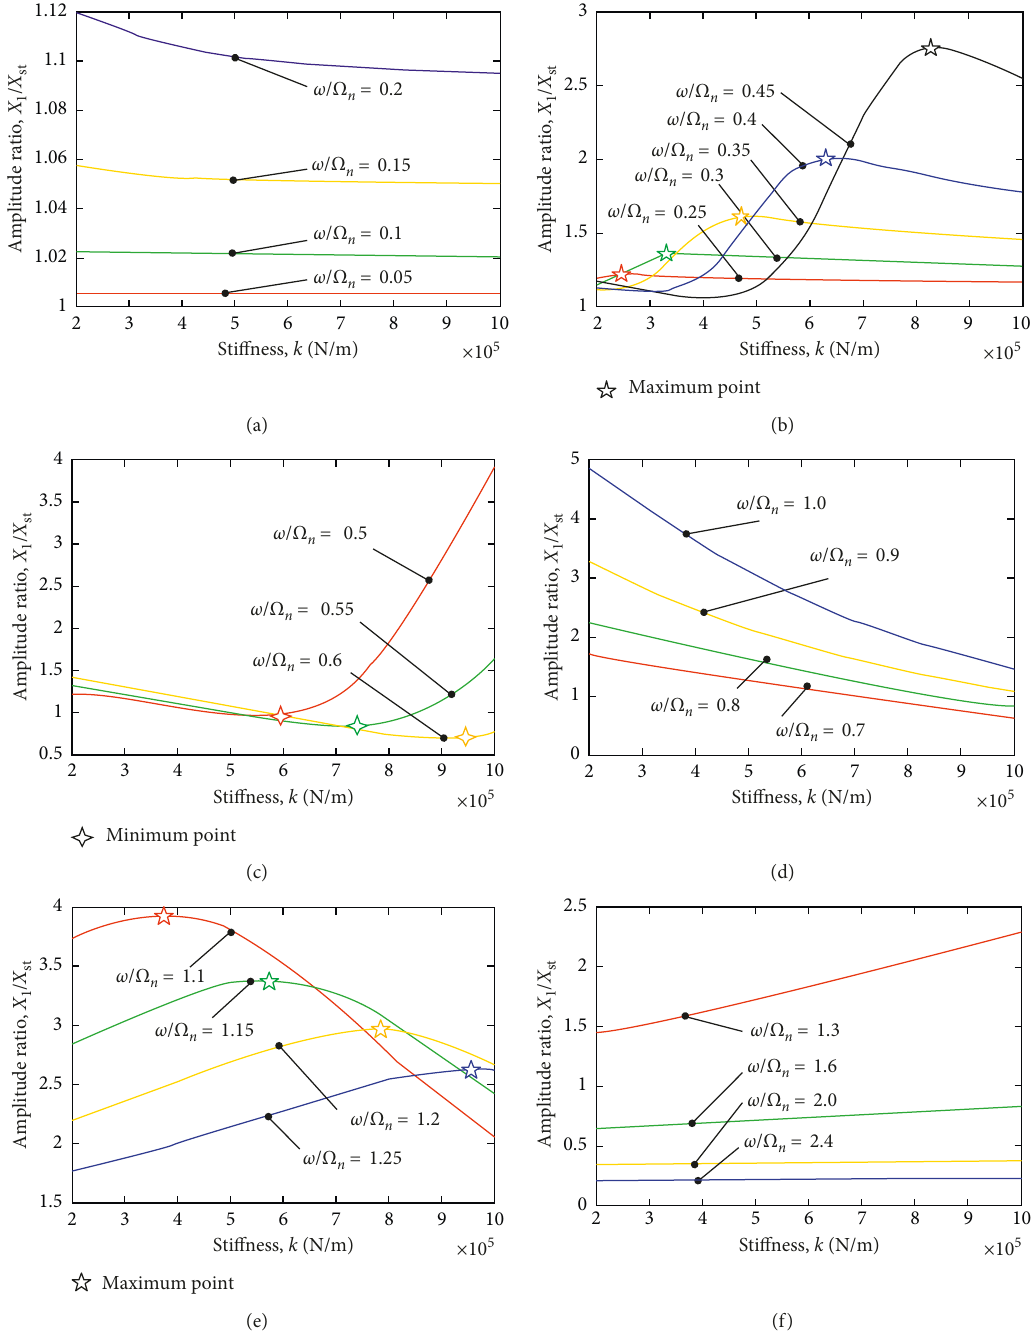
Figure 11: Amplitude ratio of the boring bar for certain frequency ratios. Frequency ratios: (a) 0.05–0.2; (b) 0.25–0.45; (c) 0.5–0.6; (d)